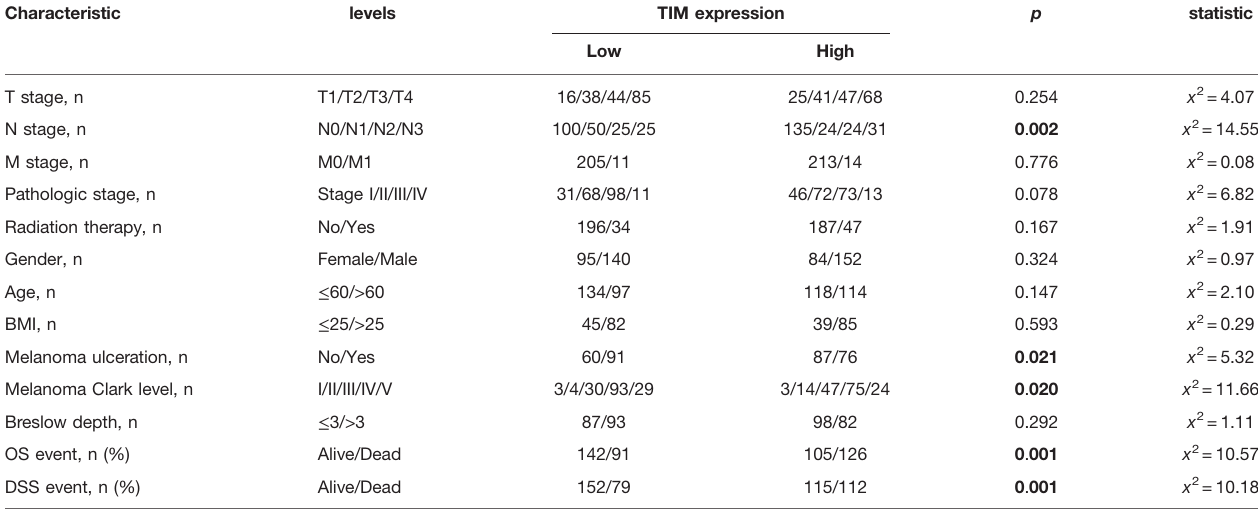
TABLE 2 | Association between TIM expression and clinicopathologic features in SKCM patients from the TCGA database. Characteristic